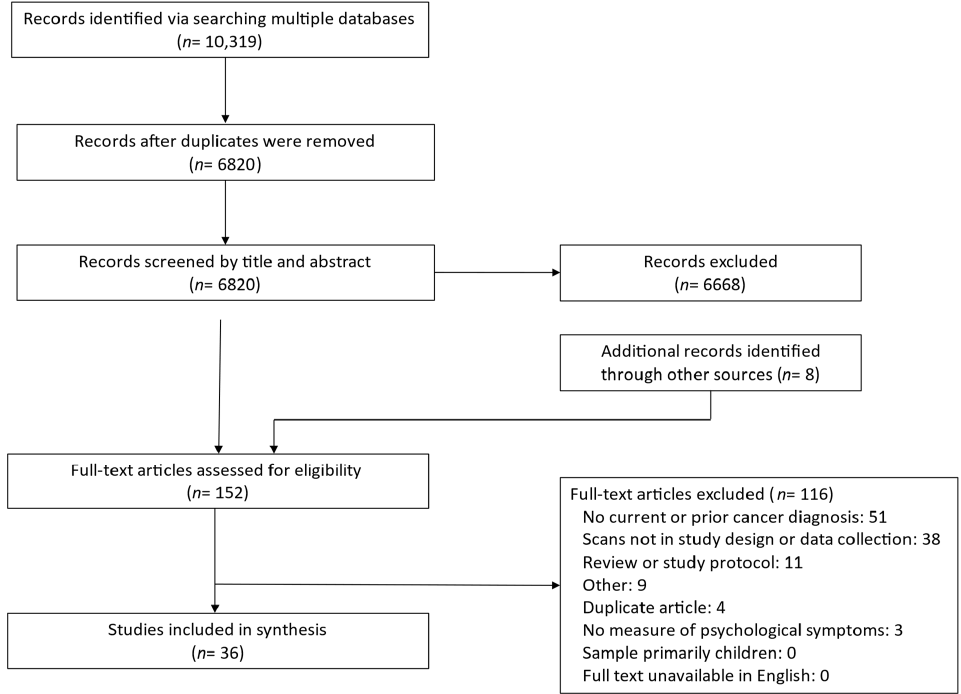
Figure 1. PRISMA diagram.